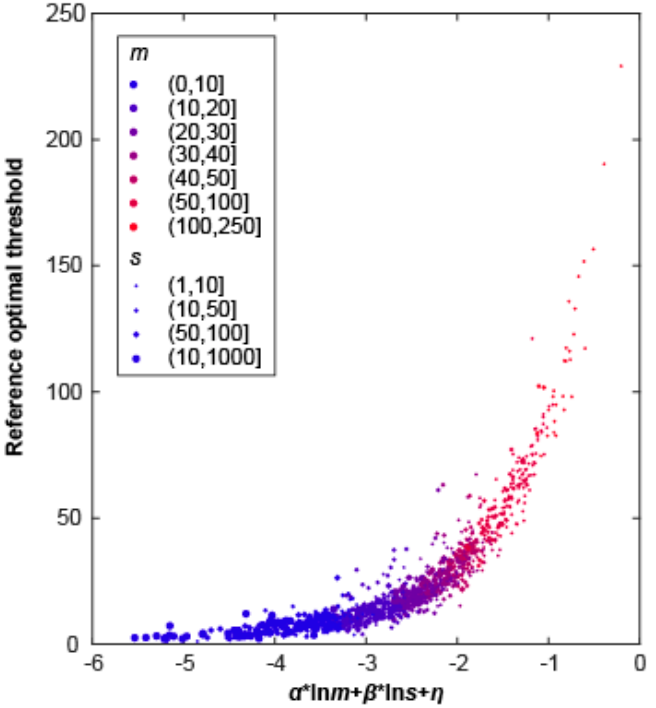
Figure 9. Relationship of the reference optimal threshold (n · W · cm − 2 · sr − 1 ) with the mean of the light magnitude m and the pixel number s of the validation objects in Test 3, with α = − 0.12, β = 0.83, and η = − 4.70.